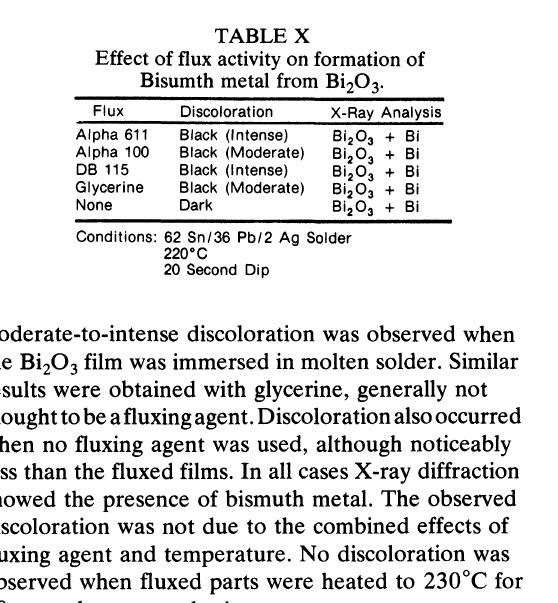
TABLE X Effect of flux activity on formation